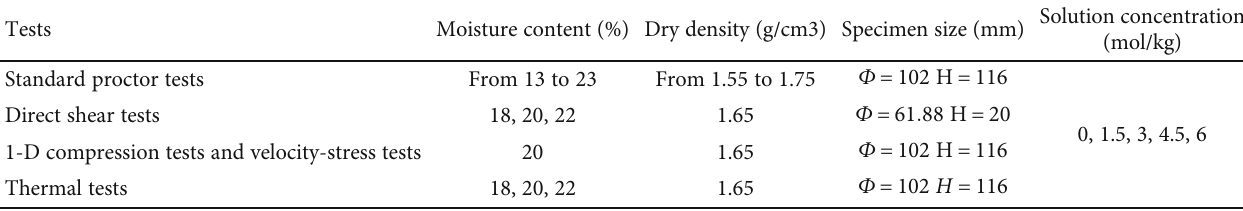
Table 2: Physical properties of specimens used in thermal and mechanical